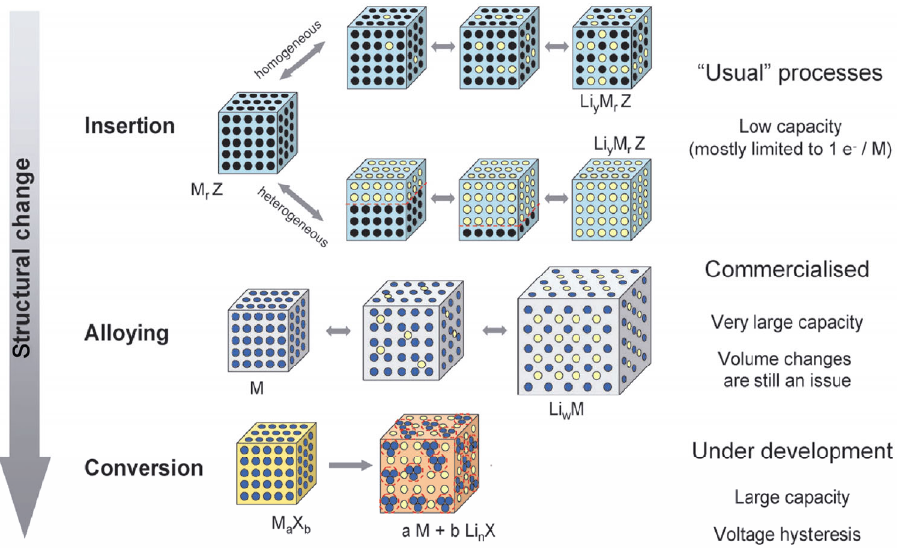
Fig. 4 Schematic representation of insertion-, alloying-, and conversion-type electrodes for LIBs. Black circles: voids in the crystal structure; blue circles: metal; yellow circles: lithium. Reproduced with permission from Ref. [56], © The Royal Society of Chemistry